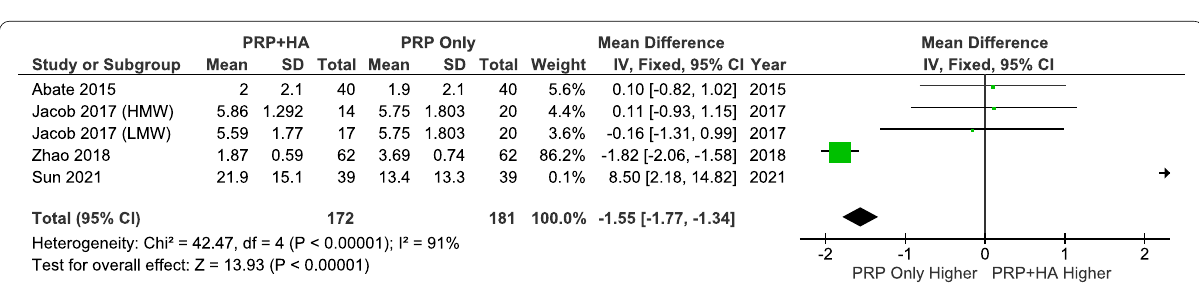
Fig. 5 Showing the Forest plot comparing the VAS scores between PRP